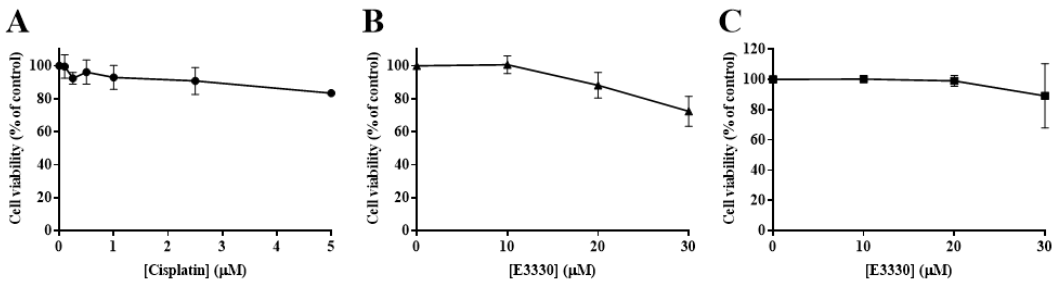
Figure 6. Viability of H1975 cells exposed to low concentrations of cisplatin or E3330 in culture medium with 2% FBS. ( A ) Effect of cisplatin (0.1–5 μM; 24 h) on cell viability, in the presence of 2%